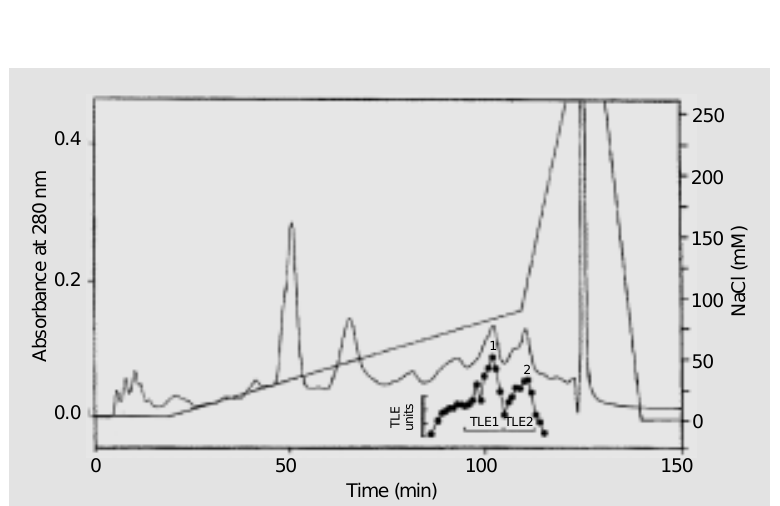
Figure 2 - Ion-exchange chromatography. The gel-filtered thrombin-like activity (Figure 1A) was applied to a DEAE-5PW (BioRad) HPLC column, equilibrated with 2.5 mM Tris-HCl, pH 7.5, and eluted with an NaCl gradient. Absorbance was monitored at 280 nm. Thrombin-like activity (filled circles) was estimated as described in Material and Methods. Peaks 1 and 2 were pooled as indicated by bars and are denoted TLE1 and